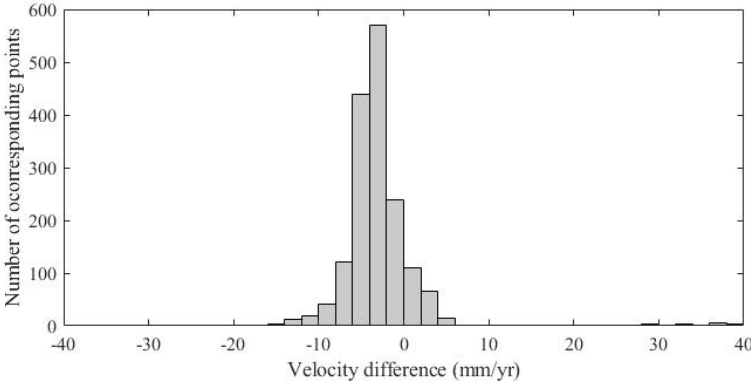
Figure 7. Histogram of the LOS velocity difference between PS and SBAS.